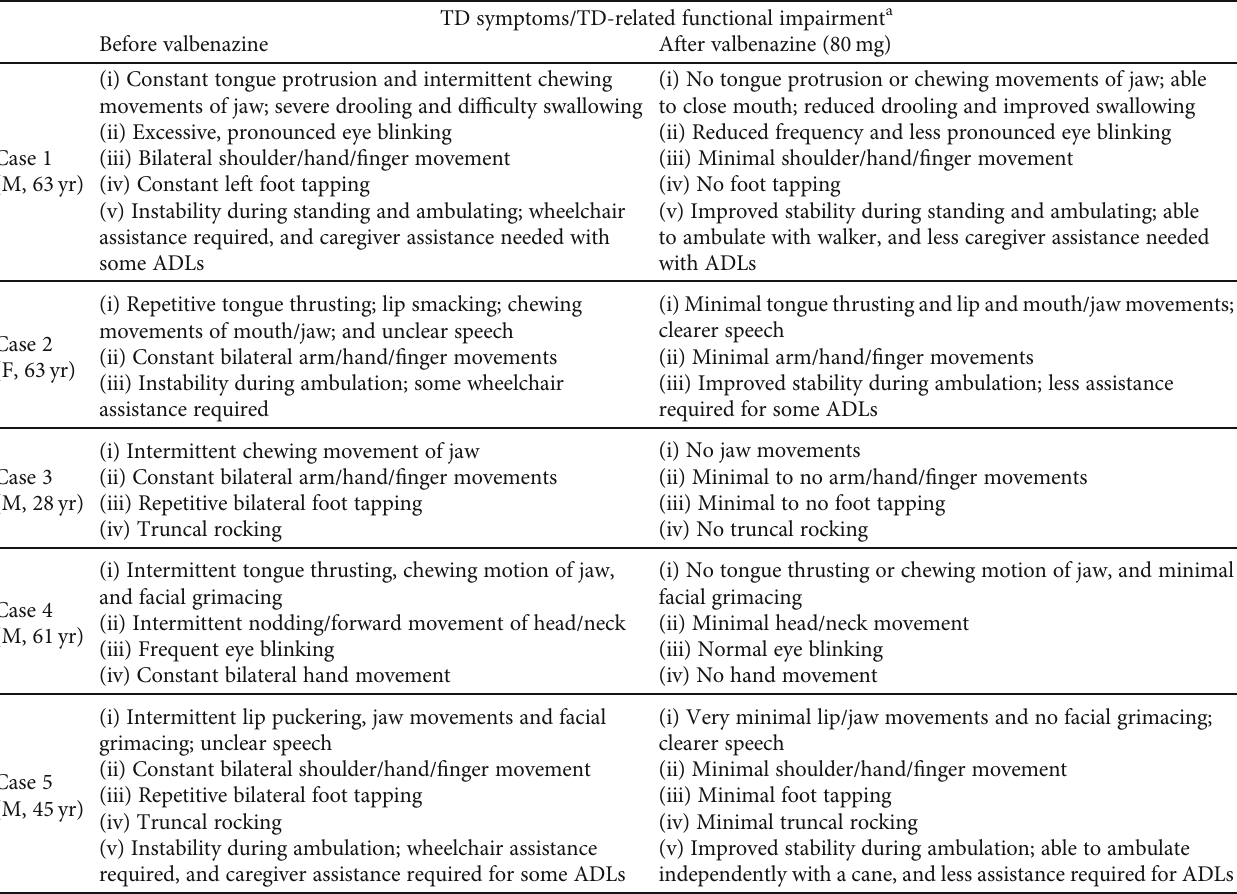
Table 2: TD symptoms and daily functioning in ID individuals before and after treatment with